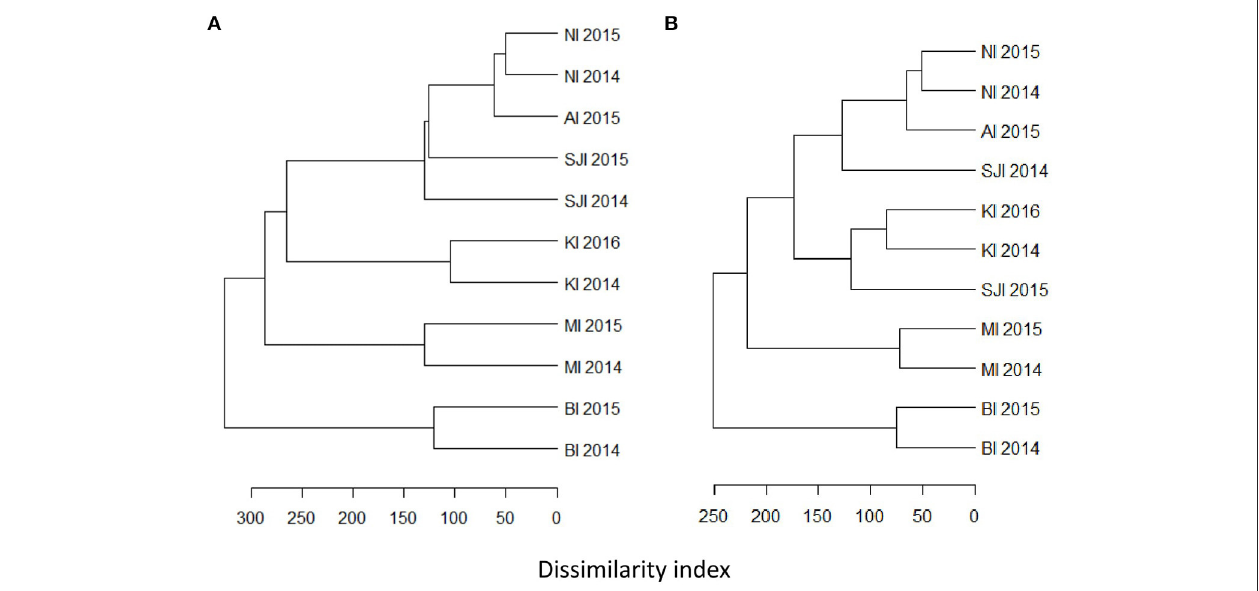
FIGURE 3 | Hierarchical clustering of frequency of occurrence of fish at each site at the level of (A) species, and (B) family. Clusters were based on dissimilarity indices calculated with the Manhattan method, and hierarchical clustering was constructed using the average agglomeration